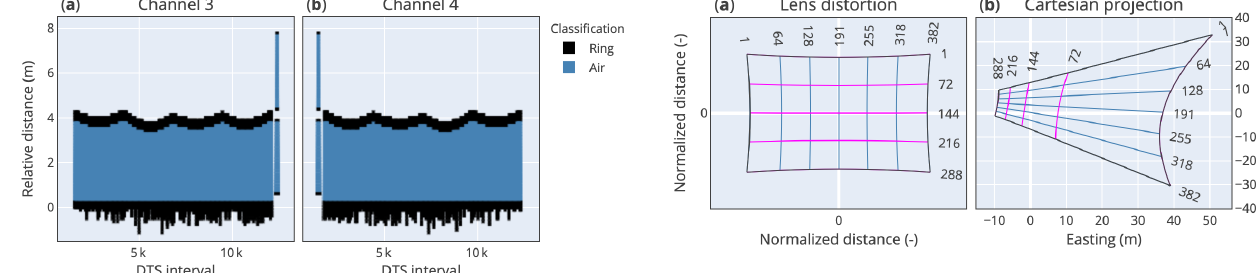
Figure A4. The projection of thermal images to real-world co- ordinates required (a) correction for lens optical distortion and (b) project after camera rotation. The numbers refer to pixel count relative to the image top-left